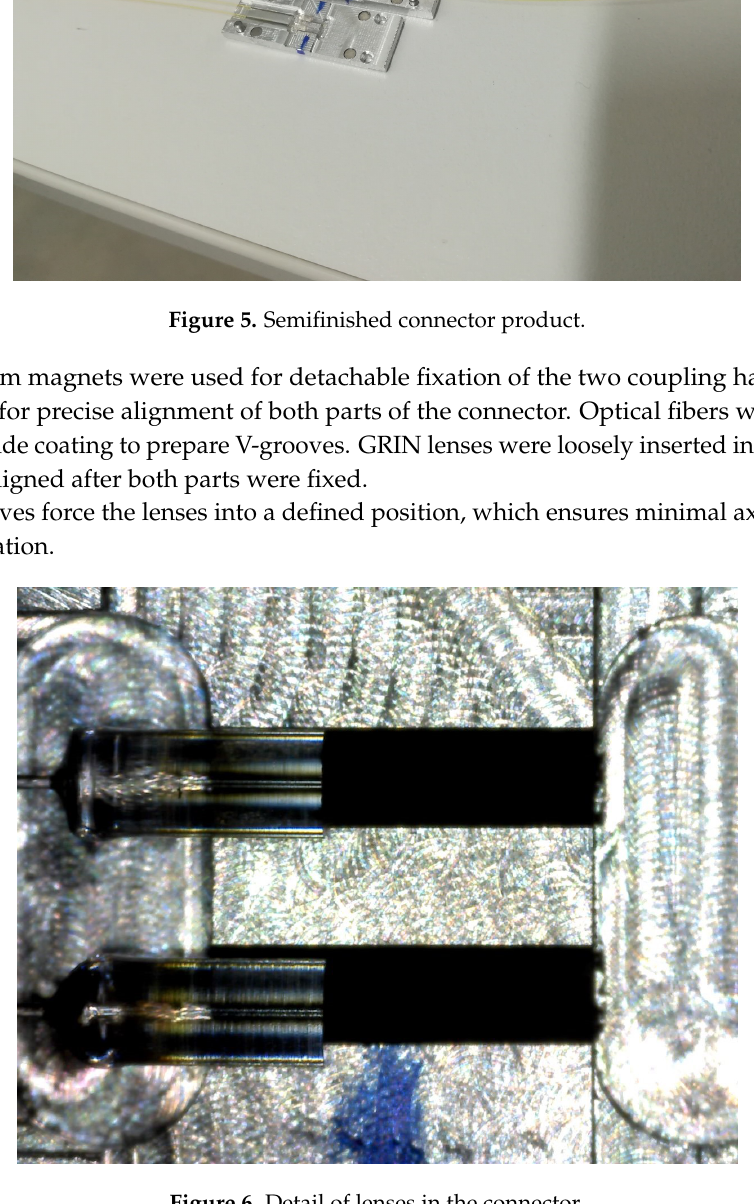
Figure 6. Detail of lenses in the